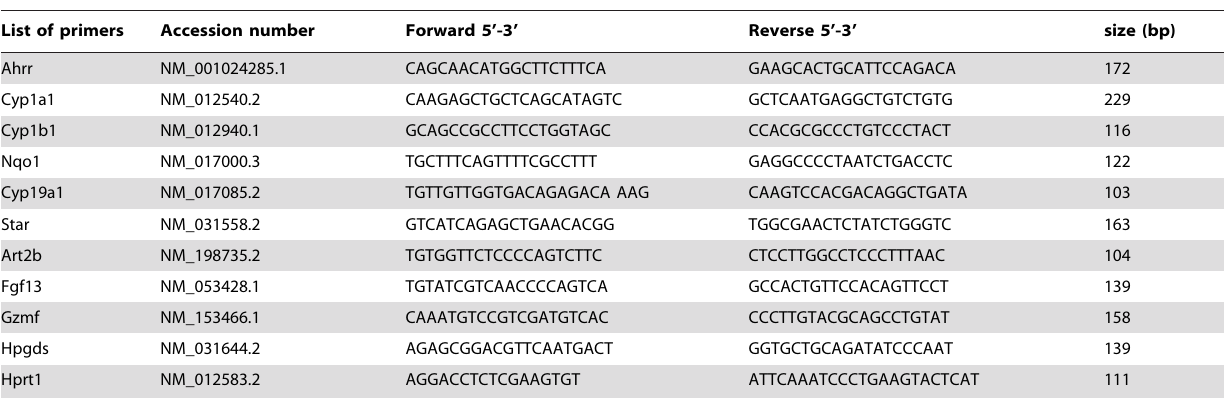
Table 1. List of primers used in the study.